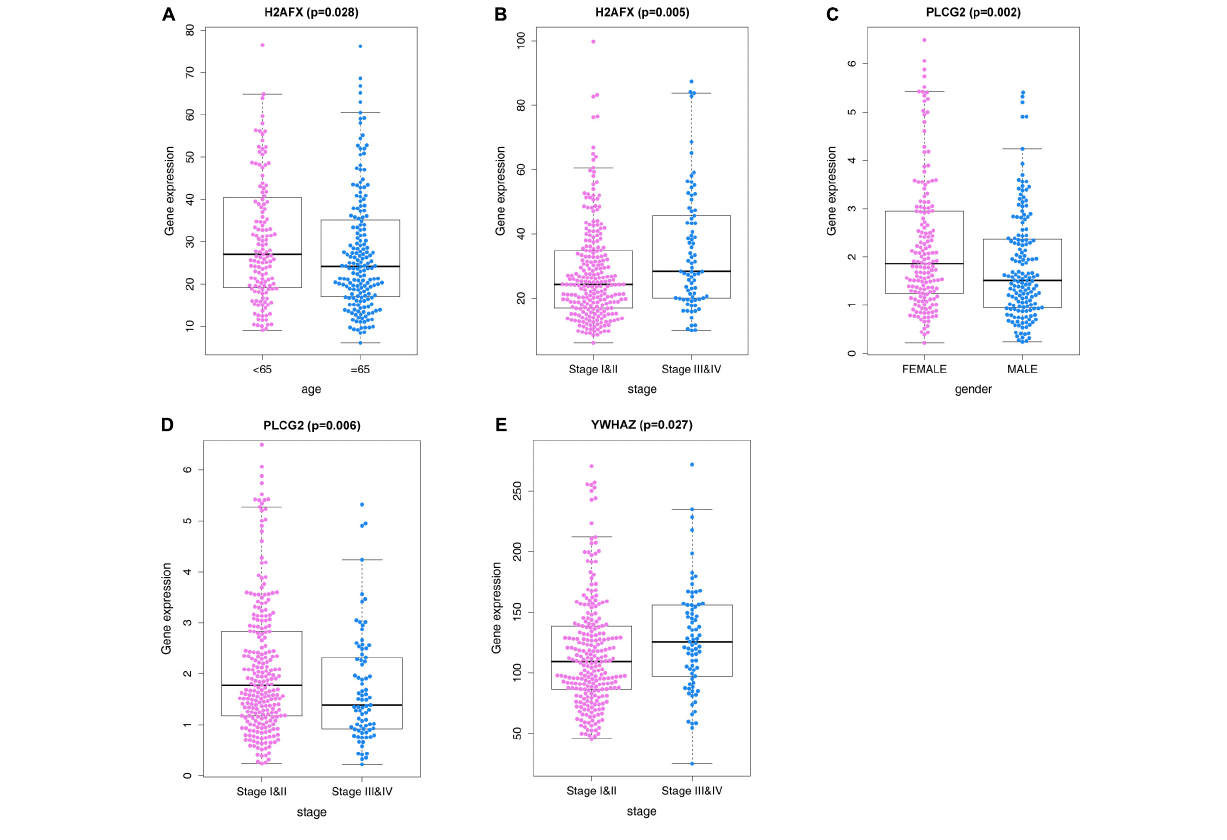
Frontiers in Cell and Developmental Biology |